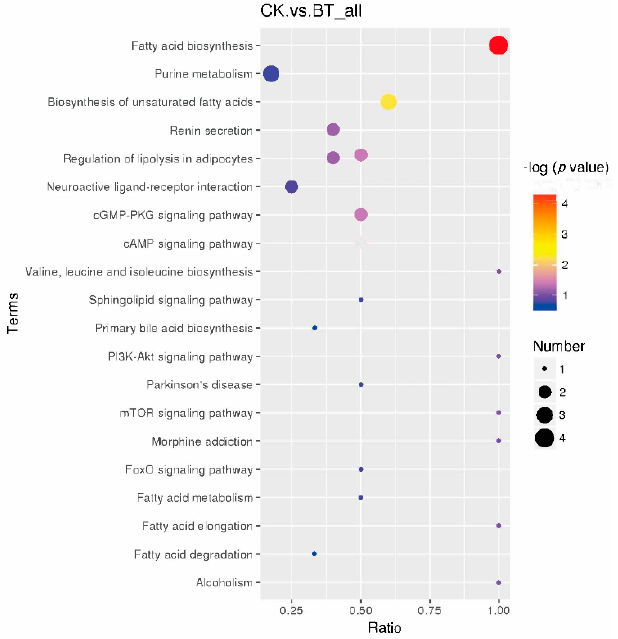
Figure 5. KEGG pathways of different metabolites in the longissimus dorsi of Black Tibetan and Chaka sheep.